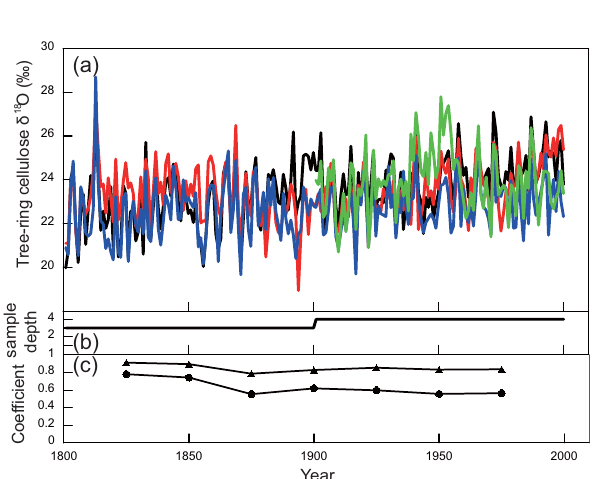
each year and subjected to cellulose extraction for each year (Sano et al., 2012). Cellulose samples (sample weight, 120–260 µg) were wrapped in silver foil, and tree-ring cellulose oxygen isotope ratios ( 18 O / 16 O) were measured using an isotope ratio mass spectrometer (Delta V Advantage, Thermo Scientific) inter- faced with a pyrolysis-type high-temperature conversion